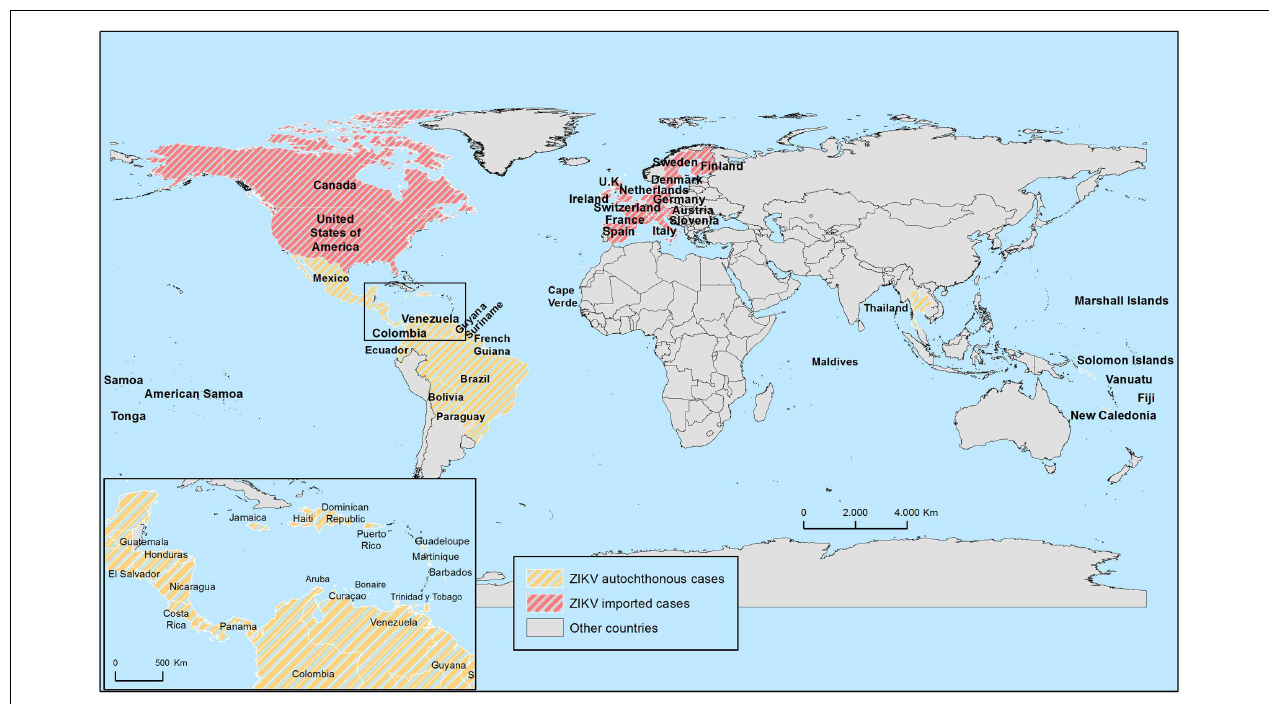
FIGURE 5 | Map showing worldwide autochthonous and imported ZIKV human cases since the last 9 months. See text for details.